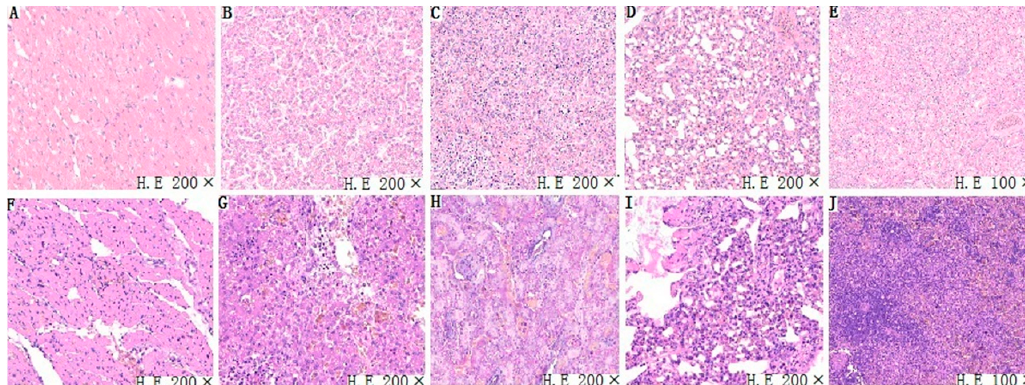
Figure 4. Representative light microscopy sections of tissues (i.e, heart, liver, spleen, lung, kidney) of FAdV-4 SDJN0105-infected chickens. ( A – E ) Heart, liver, spleen, lung, and kidney, respectively, of chickens are from the control group. Normal histopathology can be observed in the control group. ( F – J ) Heart, liver, spleen, lung, and kidney, respectively, are from the infected